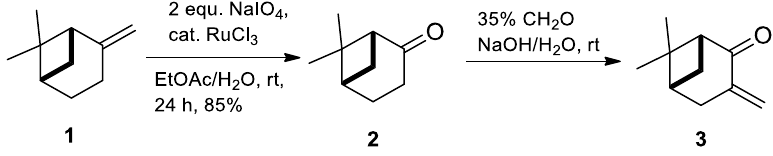
Scheme 1. Preparation of ( − )-3-methylenenopinone.